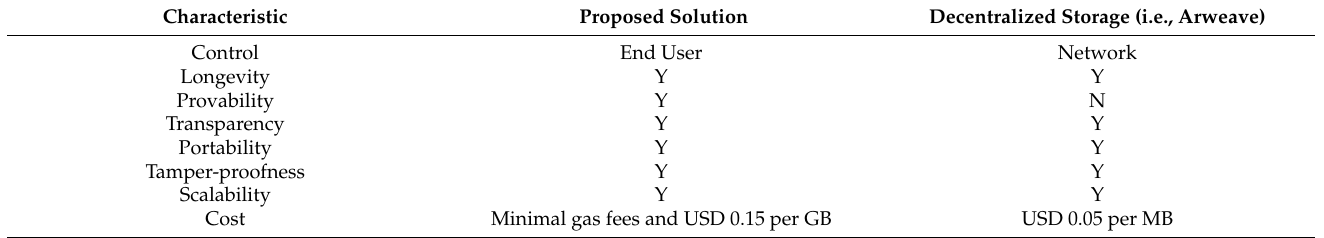
Table 4. Data storage: application comparison between Proposed Solution and Decentralized